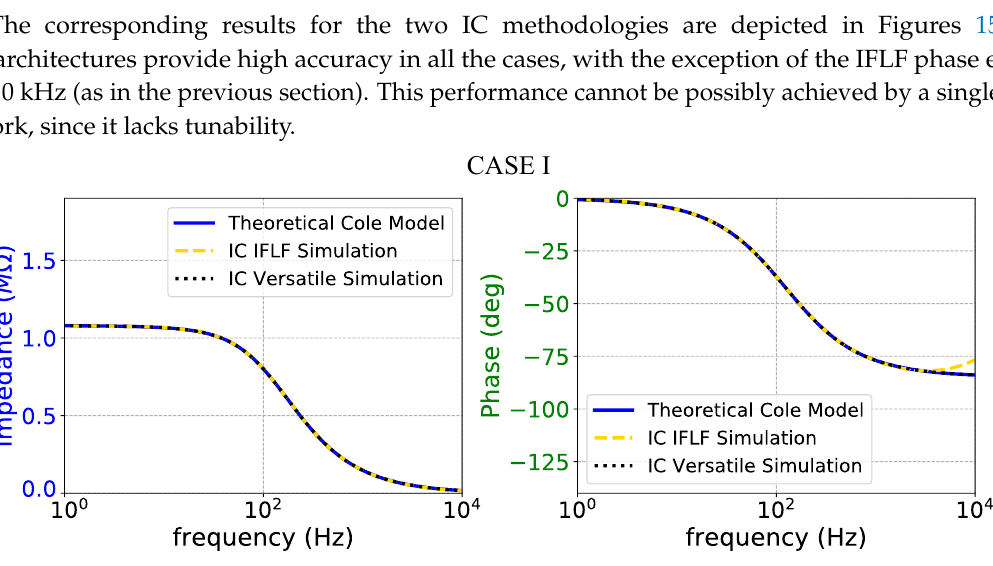
Figure 15. Impedance magnitude ( left ) and phase response ( right ) of the case I fractional-order electrode model.